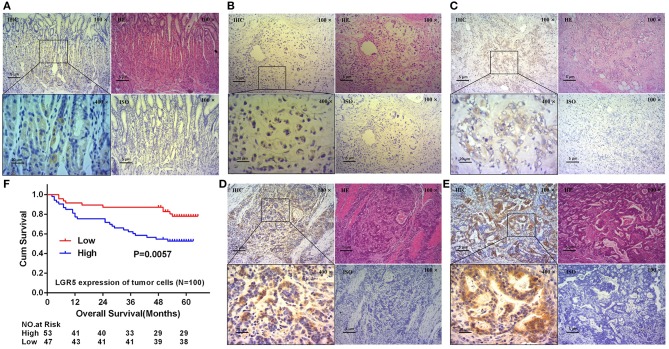
Expression of Lgr5 on normal gastric glands and GC tissues, and its prognostic significance. H&E and IHC staining on normal gastric glands and longitudinal sections shown that Lgr5 was rarely expressed in normal mucosal epithelial cells and Lgr5+ cells were mainly concentrated at the bottom of the gastric mucosa gland (A). IHC staining on GC tissues shown that Lgr5+ cells in GC exhibit four grades of Lgr5 expression intensity: negative (B), weak positive (C), positive (D), and strong positive (E). Kaplan-Meier survival analysis in GC patients (n = 100) according to the Lgr5 expression status (F). High Lgr5 expression patients showed significantly shorter 5-year OS than patients with low Lgr5 expression in their tumors by log-rank test (P = 0.0057). Cum, cumulative; GC, gastric cancer; IHC, immunohistochemistry; HE, hematoxylin-eosin staining; ISO, negative control; Lrg5, leucine-rich repeat containing G protein-coupled receptor 5; OS, overall survival.